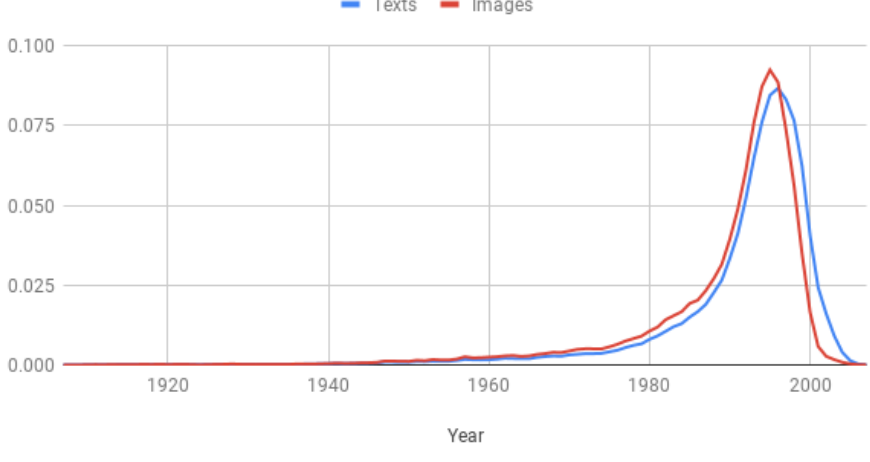
Figure 4. Prior distribution across texts and images (the abscissa denotes user birth